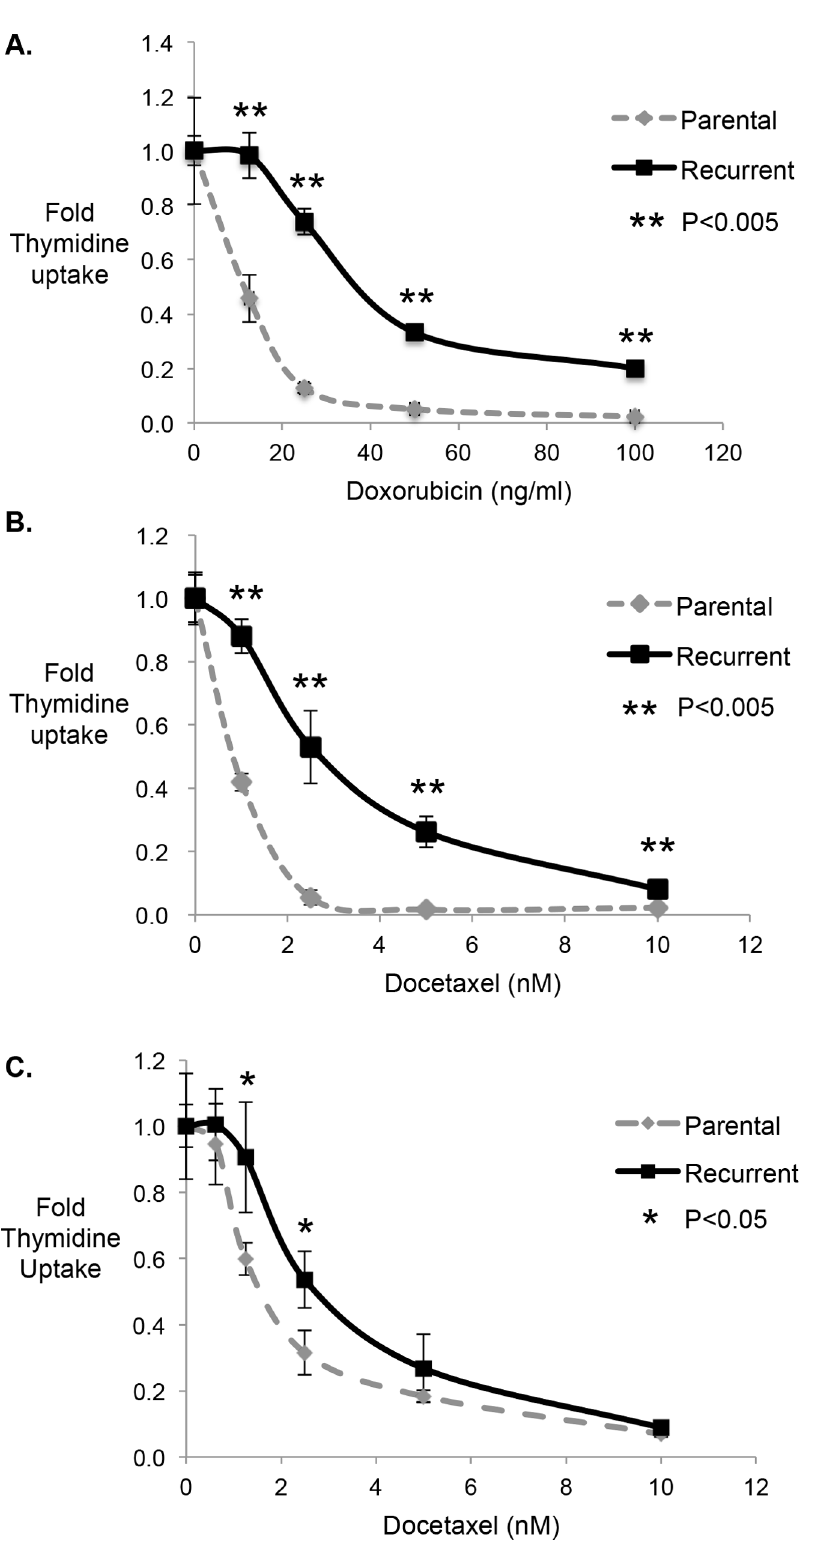
Figure 4. Tumor cells from recurrent colonies are more resistant to chemotherapy than parental tumor cells. A and B. SUM159 breast tumor cells were incubated with Doxorubicin ( A ) or Docetaxel ( B ) as in Fig. 1. Residual tumor cells were allowed to grow in the absence of chemotherapy, resulting in the evolution of ‘‘recurrent’’ colonies. Tumor cells from recurrent colonies, as well as parental tumor cells, were re- challenged with the indicated concentrations of Doxorubicin ( A ) or Docetaxel ( B ). Chemo-sensitivity was assessed by thymidine incorporation. Data for each point are expressed as fold change relative to cells cultured in media only. n=4, error bars represent S.D., *p , 0.05, **p , 0.005. C. DU145 prostate tumor cells were incubated with Docetaxel as in Fig. 1. Residual tumor cells were allowed to grow in the absence of chemotherapy, resulting